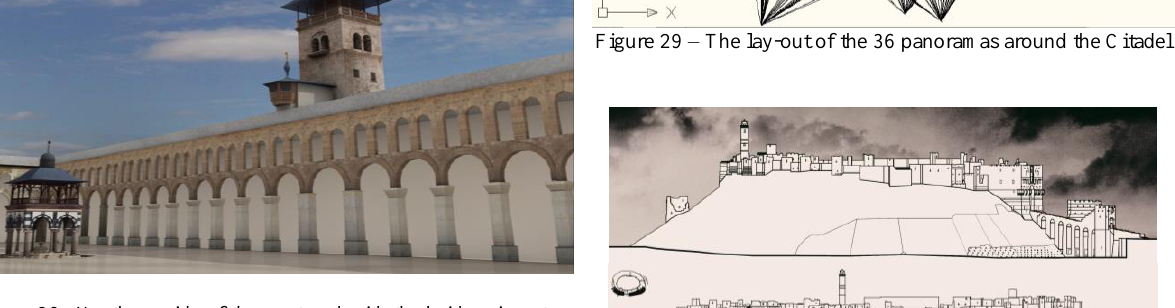
Figure 26 –Northern side of the coutyard with the bride minaret (plot and render by E.Cingolani)